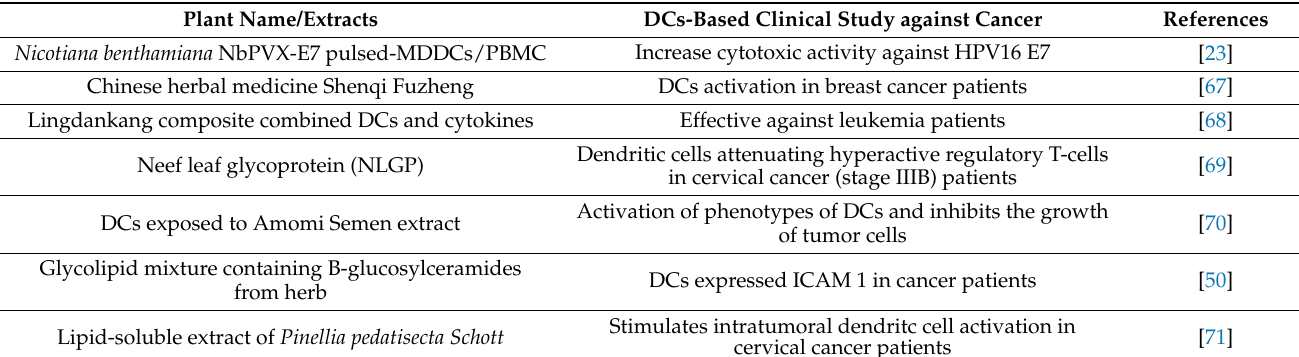
Table 6. Plant extracts on DCs-based clinical study against cancer.